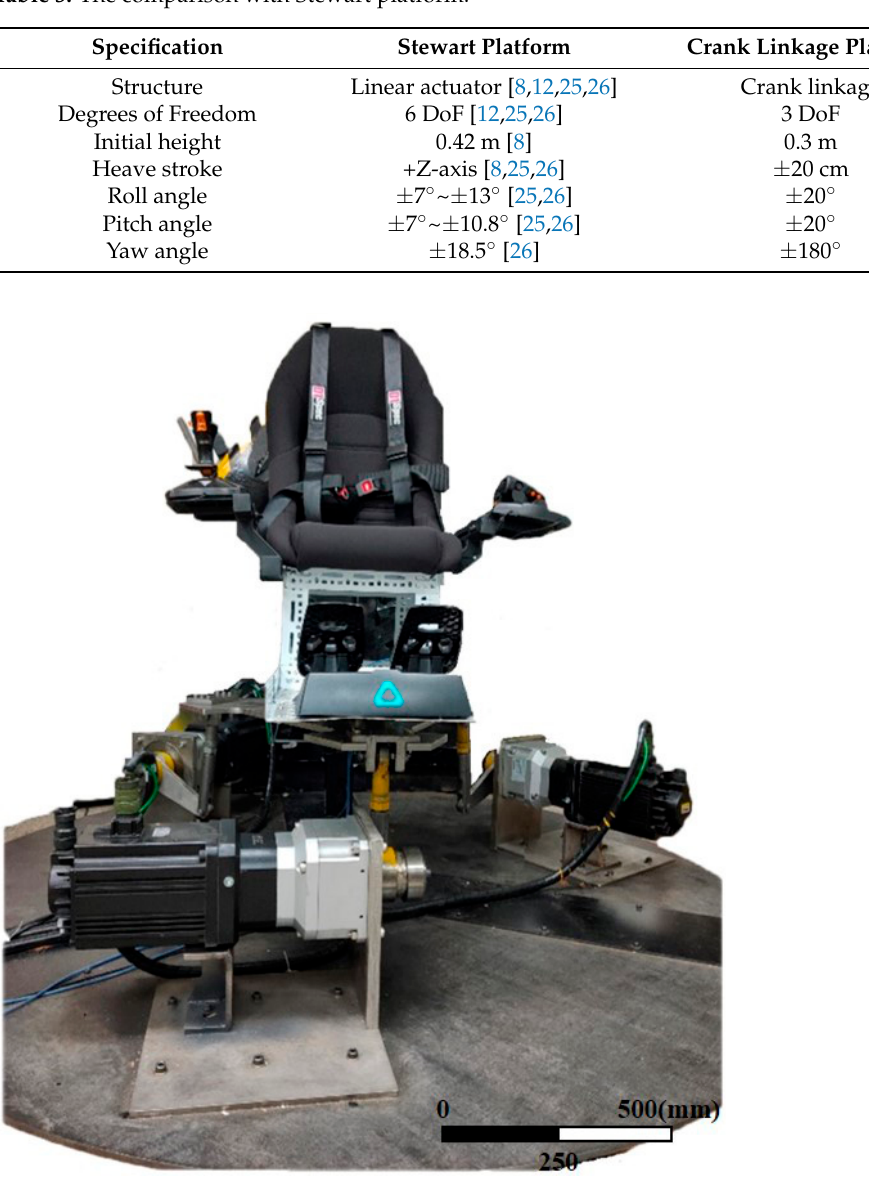
Figure 32. Complete platform.